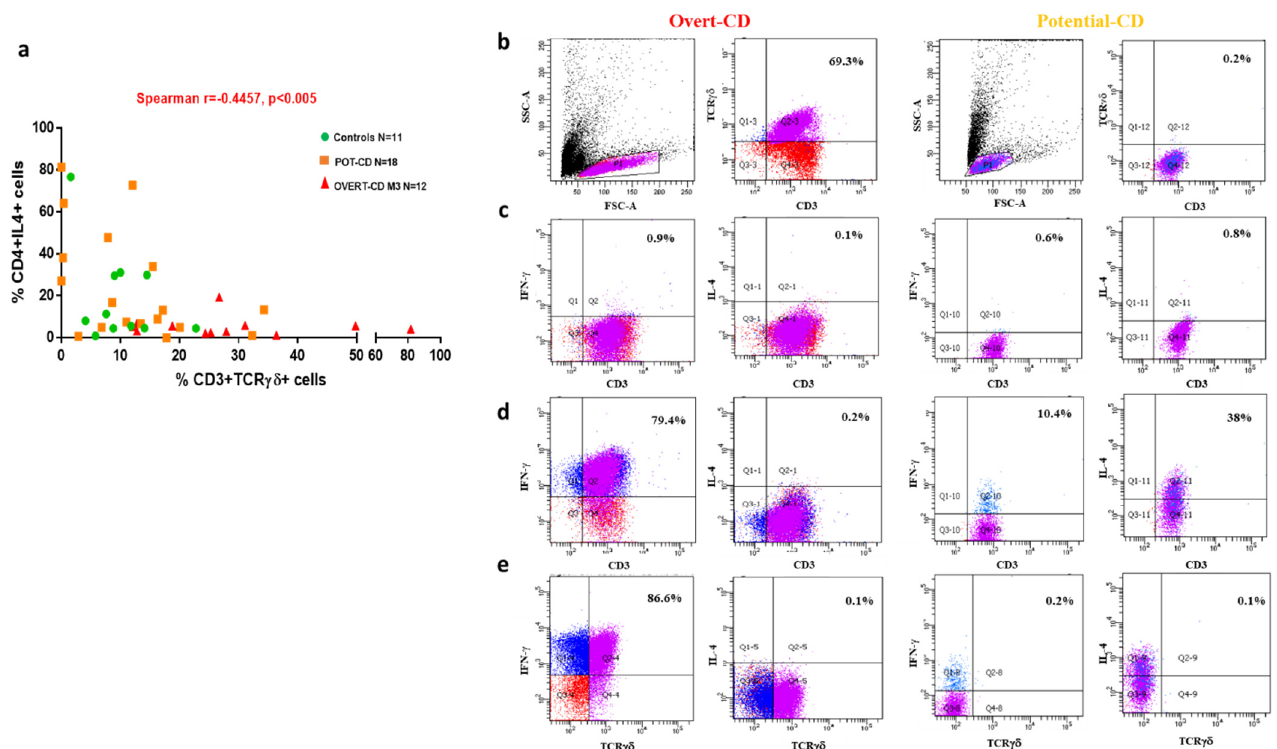
Figure 1. Correlation between the frequency of TCR γδ + T cells and IL4+ T cells in potential- and overt-CD patients. ( a ) The percentages of TCR γδ + T cells and IL4+ T cells were measured in duodenal mucosa samples of 41 children enrolled in the study ( n = 12 with overt-CD, 18 with potential-CD and 11 non-CD controls). ( b ) The densities of CD3+ and TCR γδ + cells were analyzed by a multiparametric flow cytometry in unstimulated condition, whereas the INF- γ and IL4 production was assessed without ( c ) or with PMA/Ionomycin 3 h of stimulation ( d , e ) both on freshly isolated intestinal cells and on short-term CD3+ cell lines (st-TCLs), as detailed in the materials and methods. Each symbol indicates the cell percentages detected in each subject. The correlation was assessed using the non-parametric Spearman’s rank correlation coefficient by GraphPad Prism Software, with a p ≤ 0.05 considered statistically significant. Representative flow cytometry dot plots from one overt-CD (left panels of b – e ) and one potential-CD (right panels of b – e ) patient, showing the percentage of CD3+ and TCR γδ + cells positive for IFN γ and IL4 production, are reported.